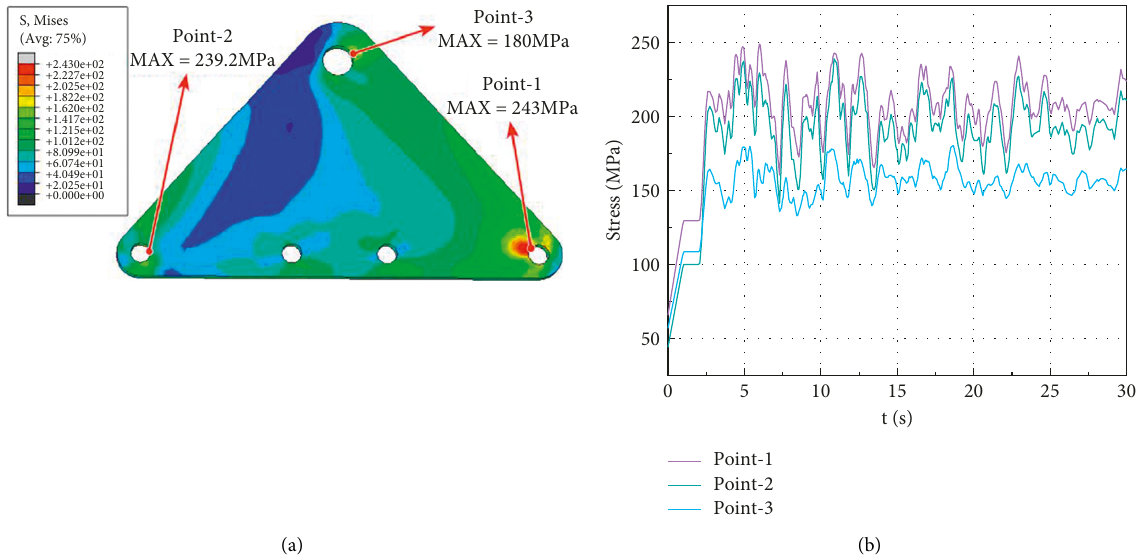
Figure 40: Triangle hanging plate connected with the ice-shedding conductor: (a) stress cloud picture; (b) stress-time curve of each hanging point.